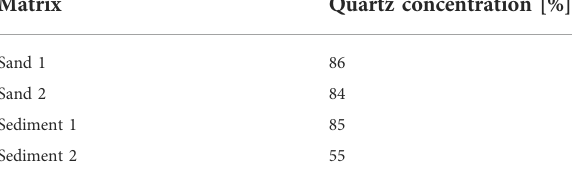
TABLE 4 Quartz concentration in the investigated matrices as determined by XRD